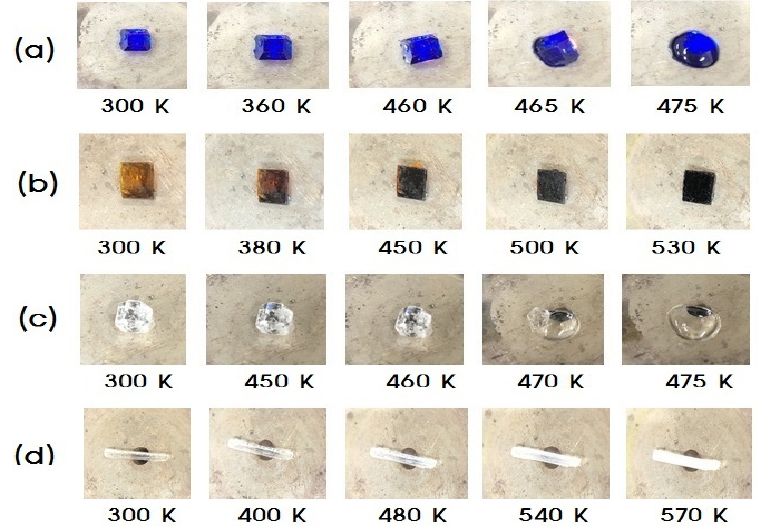
Figure 2. The states of single crystals according to the temperature ( a ) (C 2 H 5 NH 3 ) 2 CoCl 4 , ( b